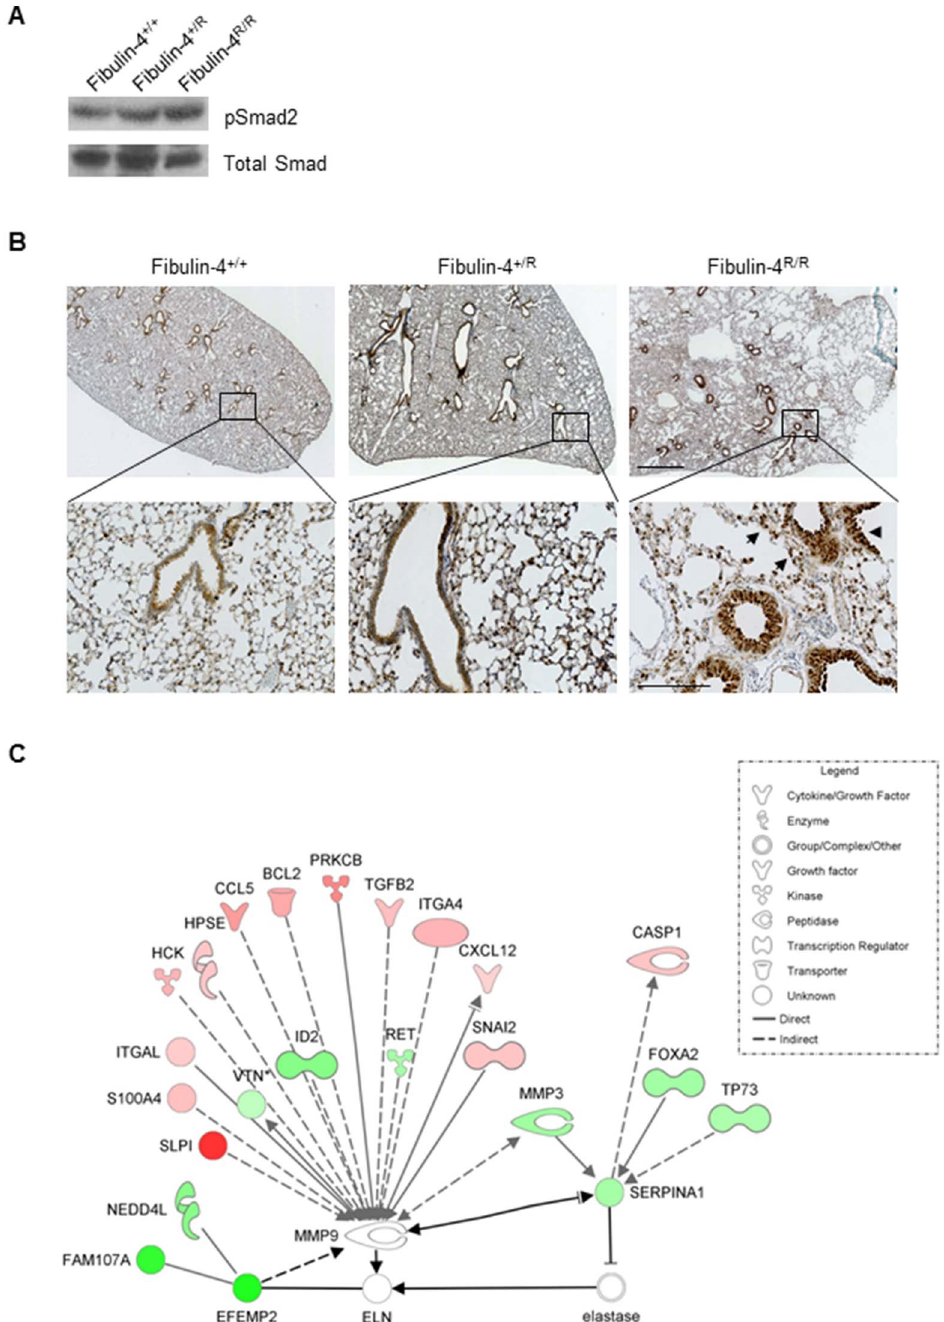
Figure 5. Increased TGF- b signaling in Fibulin-4 + /R and Fibulin-4 R/R lungs. Immunoblot analysis of pSmad2 in lung homogenates shows an increase in the amount of pSmad2 (A) and pSmad3 (B) in Fibulin-4 + /R (n=3) and Fibulin-4 R/R (n=3) lungs, compared to the total amount of Smad, and to their Fibulin-4 + / + control (n=3). (C) Increased pSmad2 staining of inflammatory and endogenous cells on Fibulin-4 + /R (n=3) and Fibulin-4 R/R (n=3) lung sections. Magnification 2.5x (scale bar 1 mm) upper panel and 20x (scale bar 200 m m) lower panel. (D) Ingenuity pathway explorer showed MMP9 as the shortest connection between Fibulin-4 and SERPINA1. SERPINA1 inhibits neutrophil elastase, which affects elastin. MMP9 itself was not deregulated in Fibulin-4 R/R lungs (n=4), but could be connected to 16 deregulated genes in Fibulin-4 R/R compared to Fibulin-4 + / + lungs (n=4, red, up-regulated; green, downregulated), suggestion altered MMP9 activity. Black arrows indicate the connection between Fibulin-4 (EFEMP2), MMP9, SERPINA1, elastase and ELN. Grey arrows indicate the connection of these genes with deregulated genes between Fibulin-4 + / + and Fibulin-4 R/R lungs. doi:10.1371/journal.pone.0106054.g005 PINA1. By calculating the shortest path between Fibulin-4 revealed, as indicated by the black arrows in Figure 5D (EFEMP2) and SERPINA1, an indirect connection of Fibulin-4 [14,24,25]. Surprisingly, by connecting Fibulin-4, MMP9 and to MMP9 and a direct connection of MMP9 to SERPINA1 was SERPINA1 (both direct and indirect) to the significantly